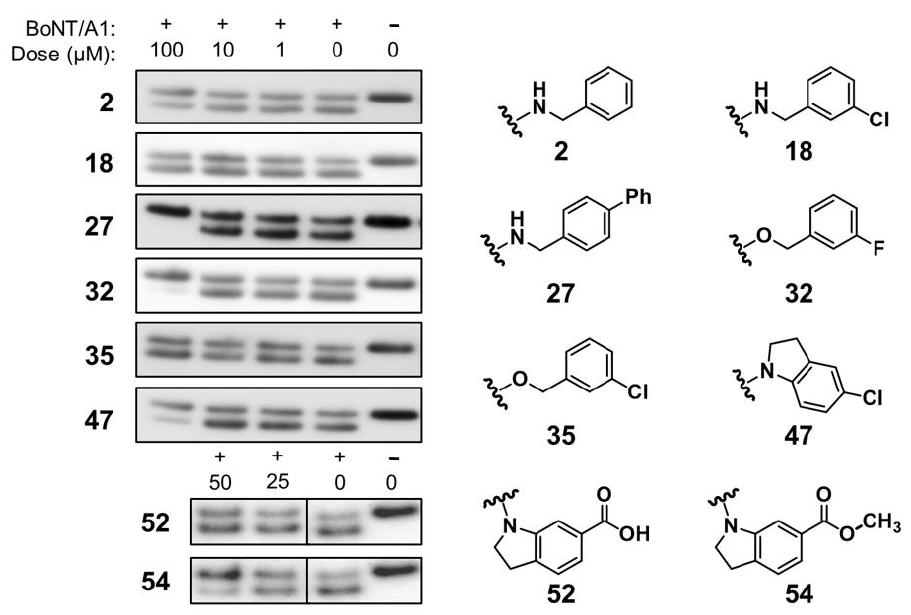
Figure 2. Cellular evaluation of PPO inhibitors. Western blots are representative images of each sample, full images can be found in Figure S1. The upper bands represent intact SNAP-25, and the lower bands represent cleaved SNAP-25. The positive control group was exposed to BoNT/A, and the negative control group was not. Both control groups were treated with cell media containing 1% DMSO.